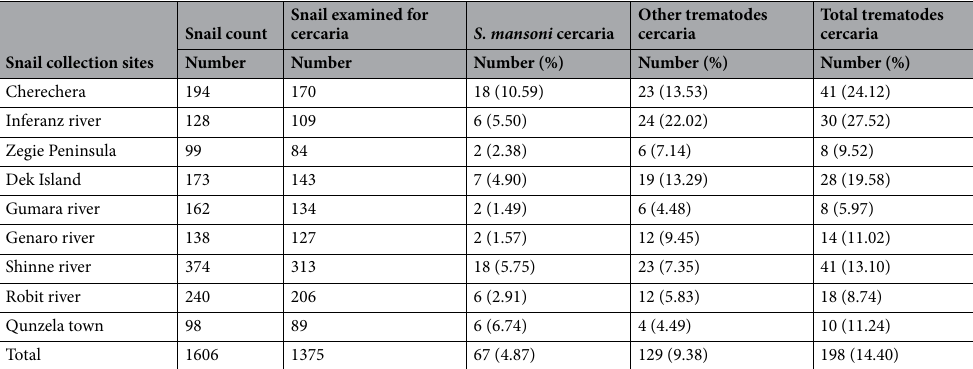
Table 3. Prevalence of Schistosoma mansoni and other trematodes infection among Biomphalaria snail species.